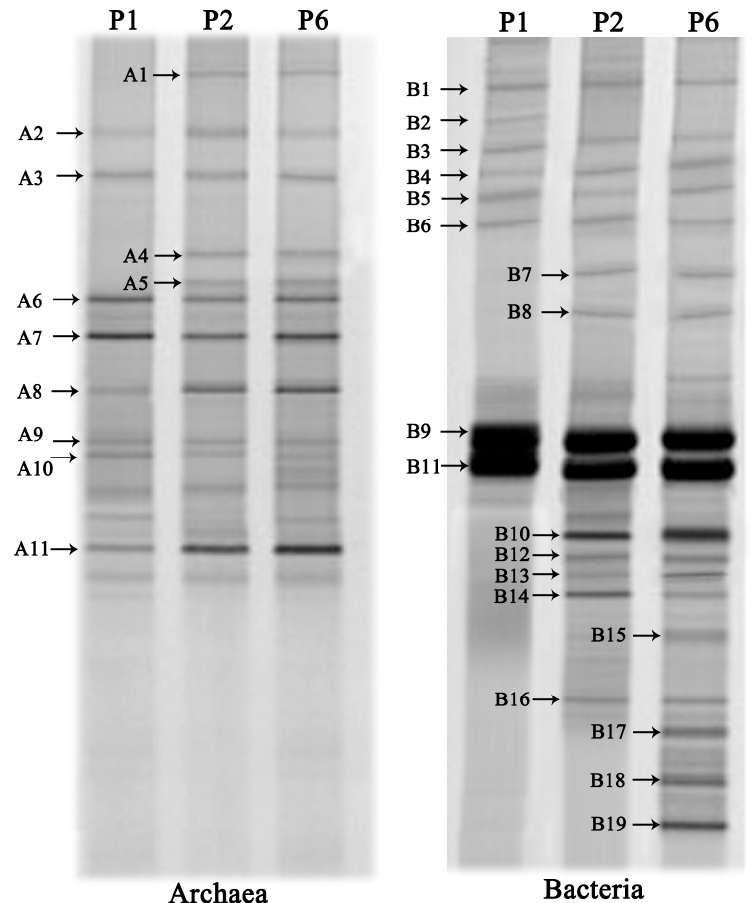
Figure 7. The DGGE profiles of archaea and bacterial 16S rRNA genes from the samples of digestion reactor in the last day of P1, P2 and P6. The gels with band were collected from the DGGE gel and labeled as bands A1–A11 (for archaea) and B1–B19 (for bacteria). The sequencing results of each band are shown in Table 5.